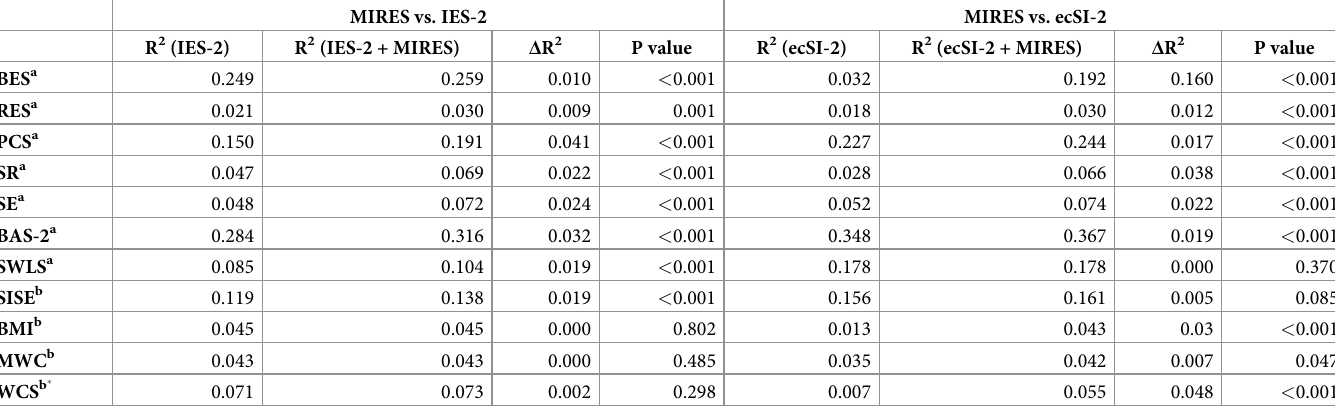
Table 6. Incremental variance in outcome measures accounted for by